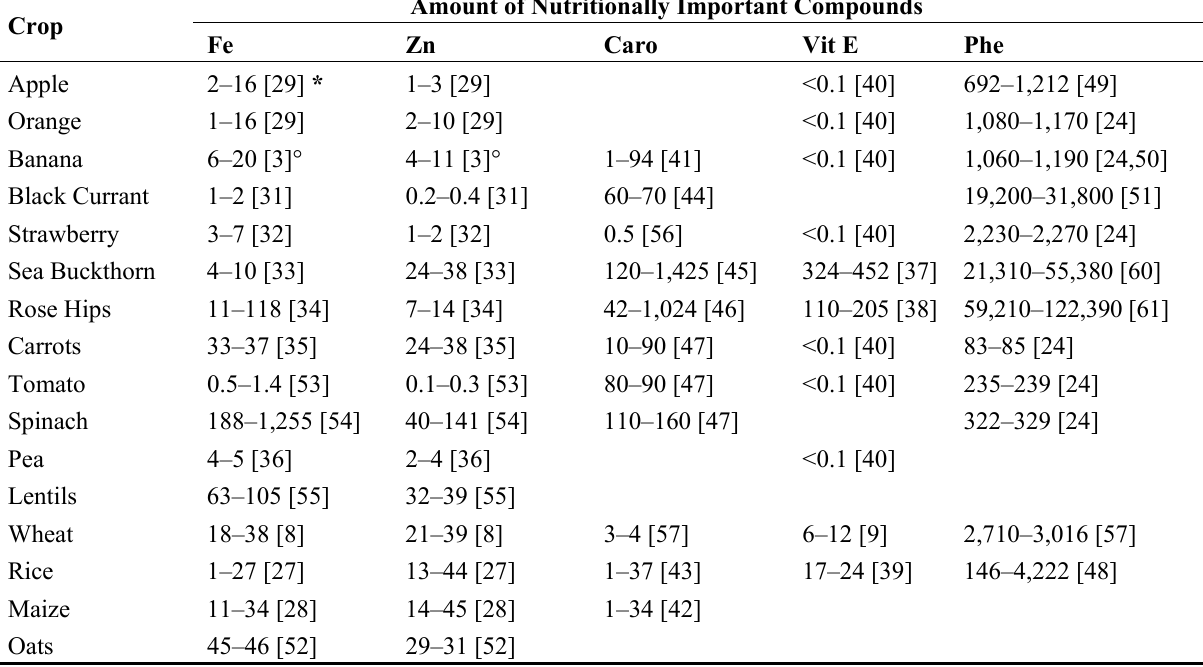
Table 1. Variation in content of Iron (Fe; mg/kg), Zinc (Zn; mg/kg), Total Carotenoids (Caro; mg/kg), Vitamin E activity (Vit E; mg/kg) and Total Phenolics (Phe, mg/kg) in a number of representative fruits, berries, vegetables, legumes and